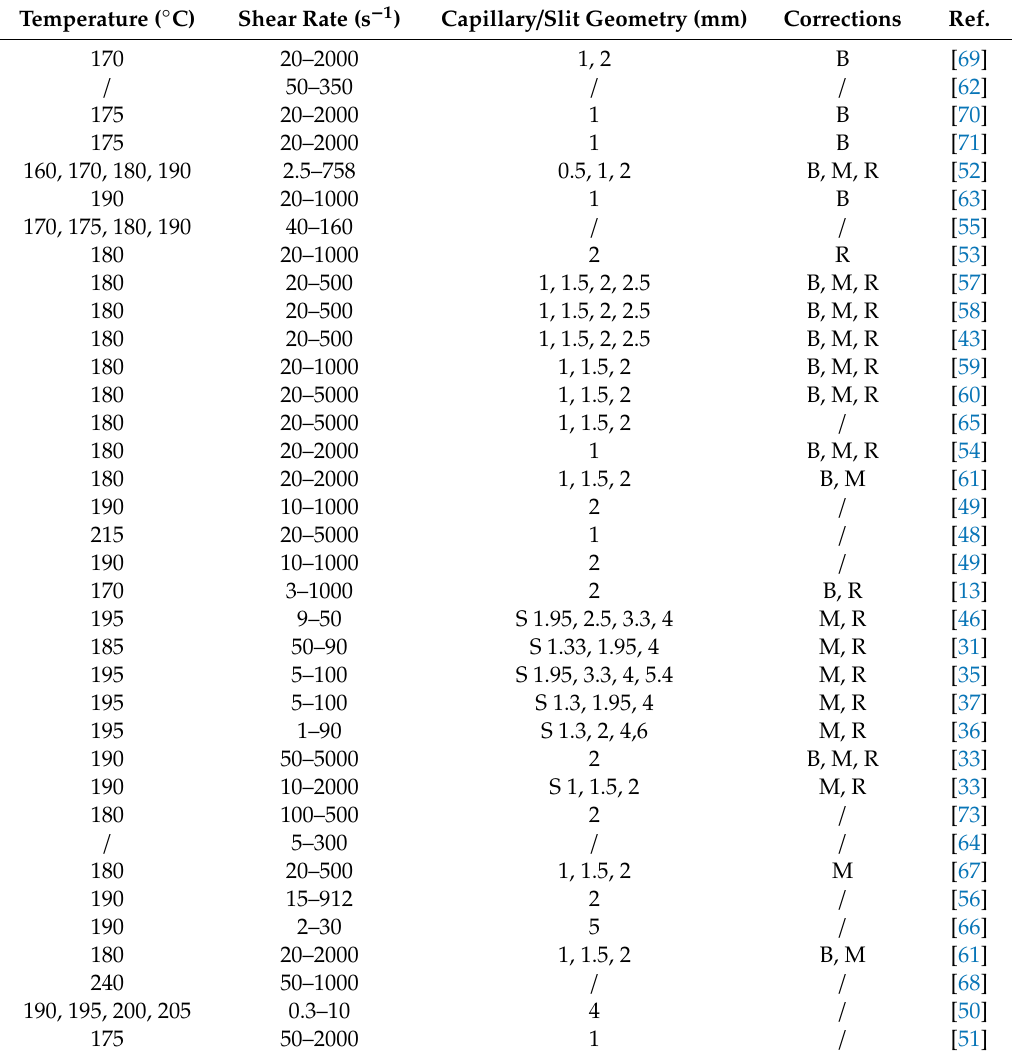
Table 4. Test conditions imposed with pressure-driven viscometry in literature. “S” stands for slit rheometer, and “B”, “M”, and “R” stand for the Bagley, Mooney, and Rabinowitsch correction procedures,